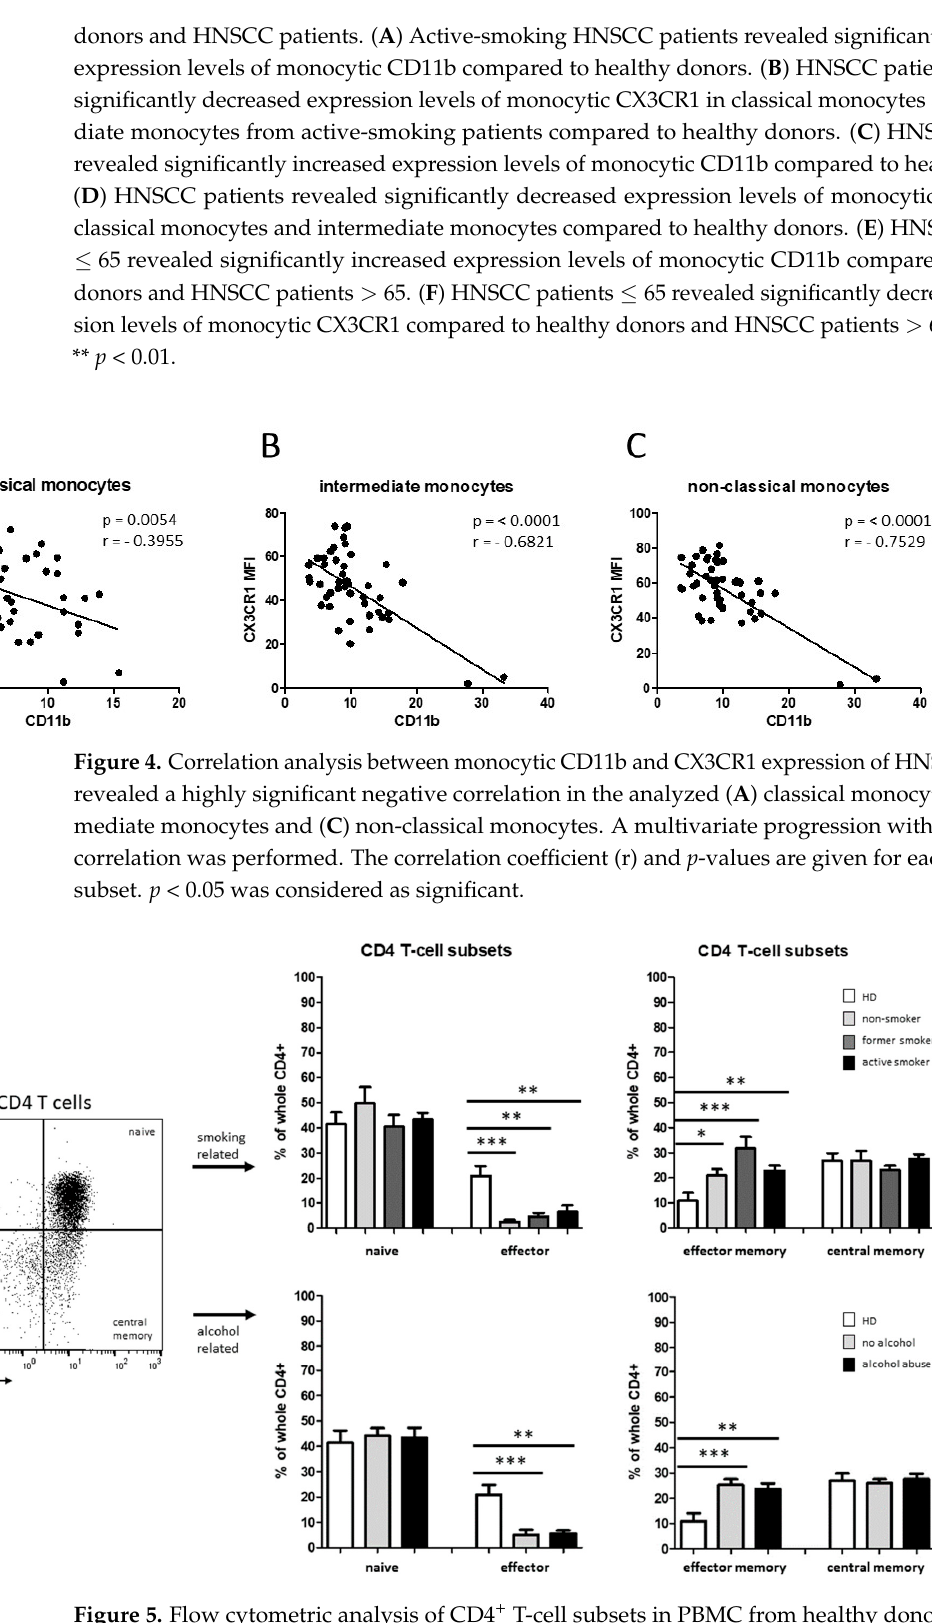
Figure 5. Flow cytometric analysis of CD4 + T-cell subsets in PBMC from healthy donors as well as smoking and alcohol-abusing HNSCC patients. Example gating scheme and percentages of naïve, effector, effector memory, and central memory T cells within CD4 + T cells. * p < 0.05; ** p < 0.01; *** p <